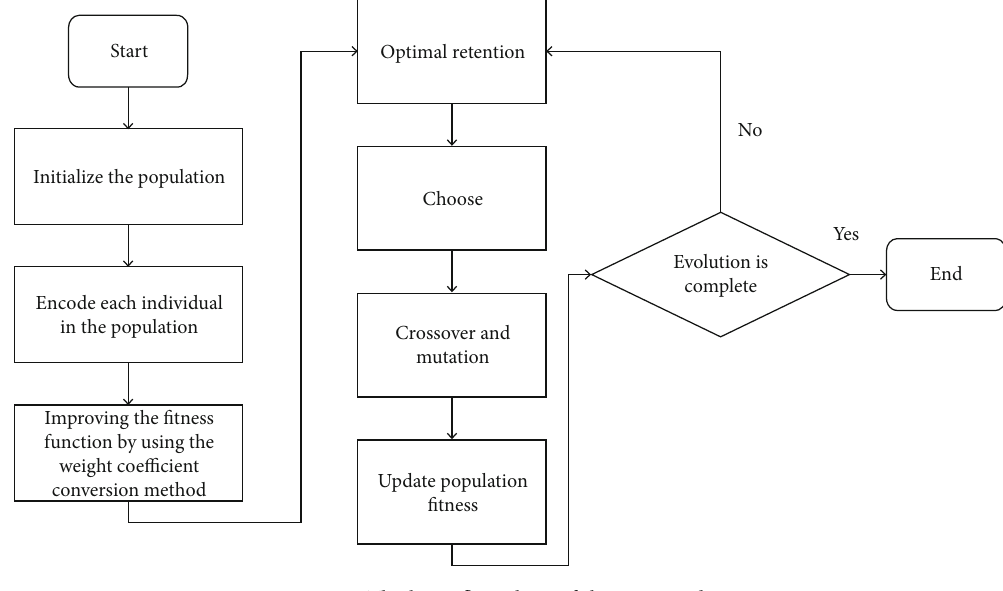
Figure 2: The basic fl ow chart of the improved GA.